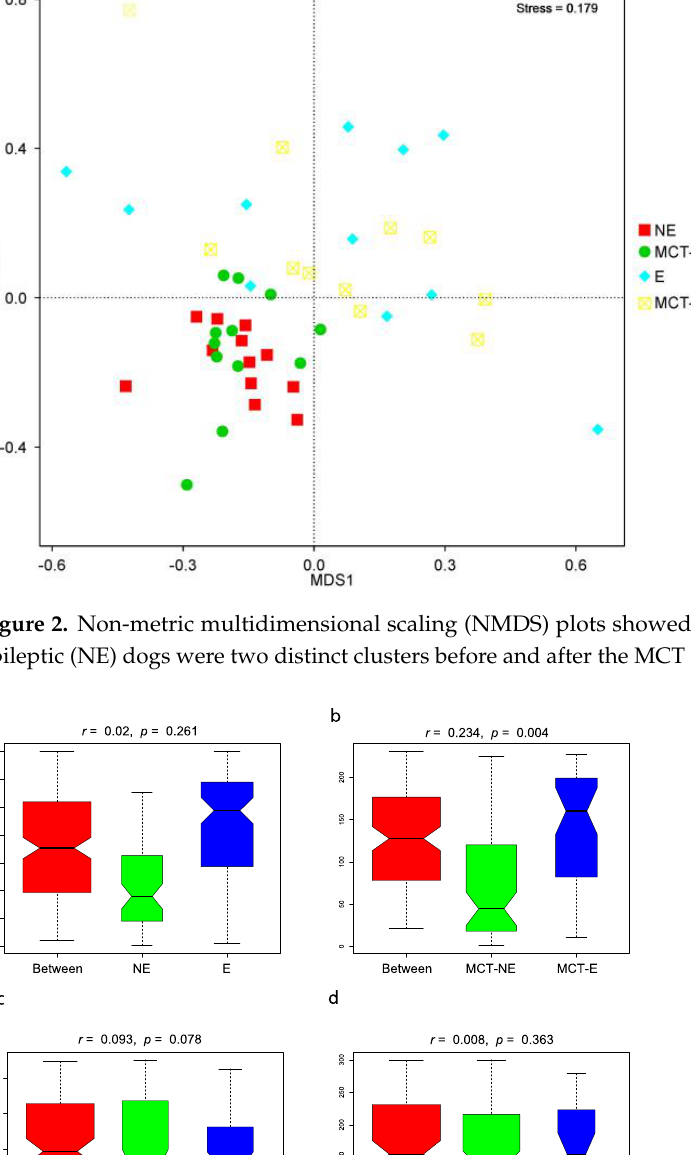
Figure 3. Analysis of similarity (Anosim) between epileptic (E) and non-epileptic (NE) dogs in base- line conditions (( a ): E vs. NE) (Anosim r = 0.002; p = 0.261), between E and NE dogs after the MCT diet (( b ): MCT-E vs. MCT-NE) (Anosim r = 0.234; p = 0.004), in NE dogs before and after the MCT diet (( c ): NE vs. MCT-NE) (Anosim r = 0.093; p = 0.078) and E dogs before and after the MCT diet (( d ): E vs. MCT-E) (Anosim r = 0.008; p = 0.363). Concerning the relative abundance of fecal bacteria in basal conditions (D0), dogs with IE showed a higher abundance of Bacilli ( p = 0.006) class, Lactobacillales ( p = 0.041) order, and Lactobacillus ( p = 0.004) genus compared to non-epileptic dogs. After 1 month of dietary intervention (D30), epileptic dogs showed a significantly higher abundance of